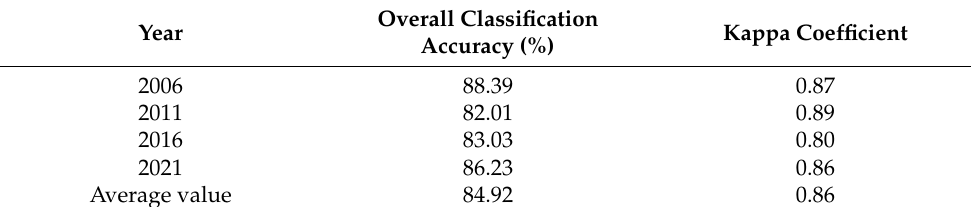
Table 1. Kappa coefficients for LULC types from 2006 to 2021.